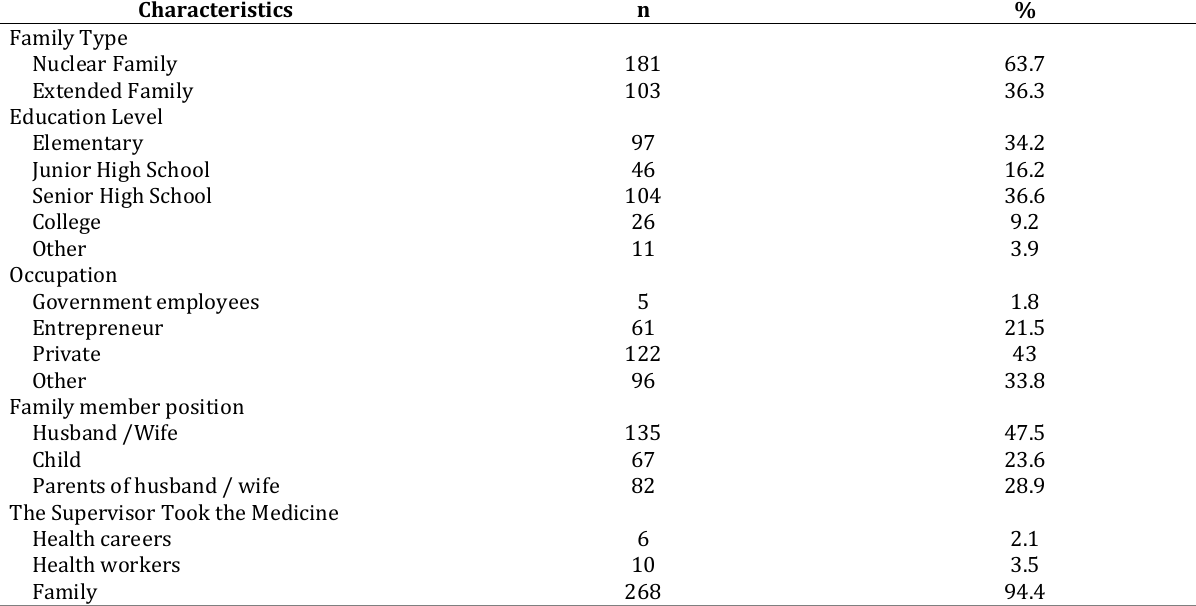
Table 1. General Data of Research Respondents